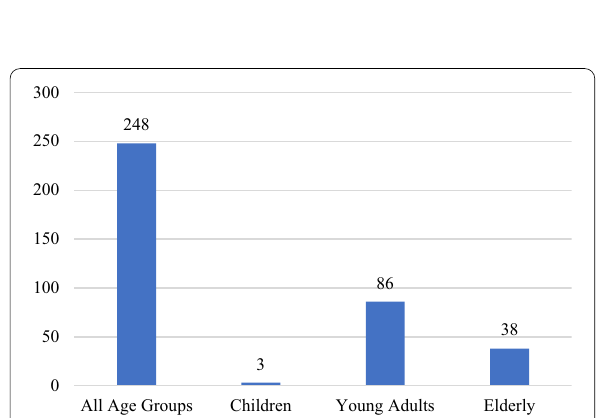
migraineurs are suffering from stigmatization. Two hun- dred fifteen (55.8%) do not have the knowledge to deal with migraineurs. Two hundred forty-four (63.4%) con- sidered migraine to cause a huge psychological and social impact (Table 3).